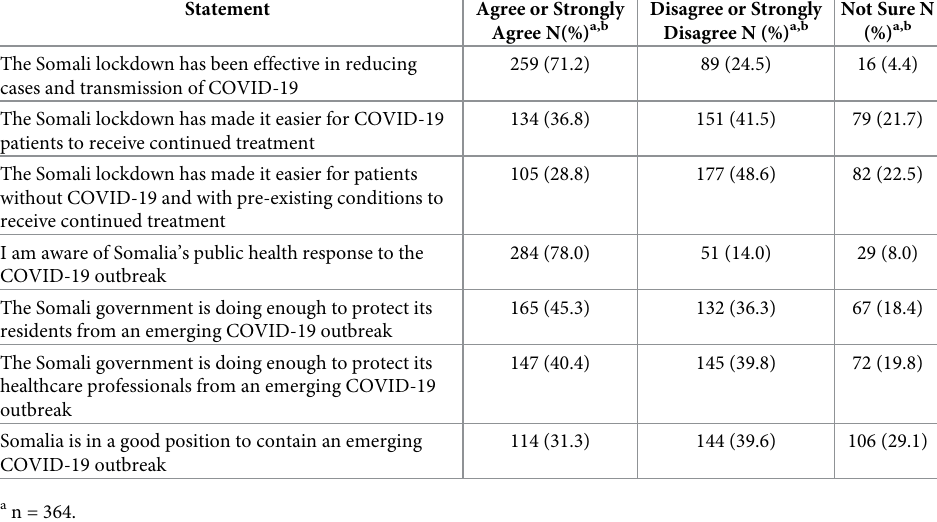
Table 5. Evaluation of national action against COVID-19 among Somali healthcare